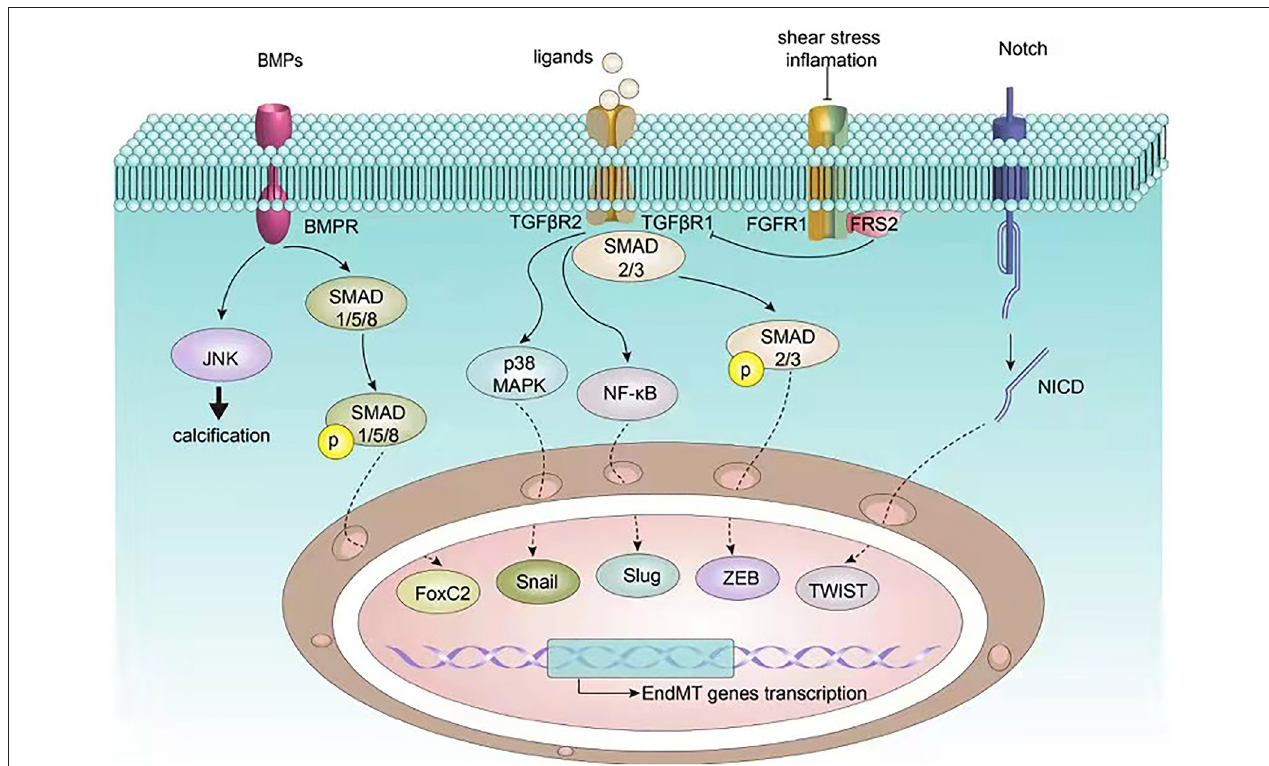
FIGURE 2 | Signaling pathways involved in EndMT in atherosclerosis. EndMT related transcription factors such as Snail, Slug, ZEB, TWIST, and FoxC2 are governed by upstream signalings including BMP, TGF- β , FGF, and Notch, which in turn regulate endothelial and mesenchymal gene expression, ultimately inducing